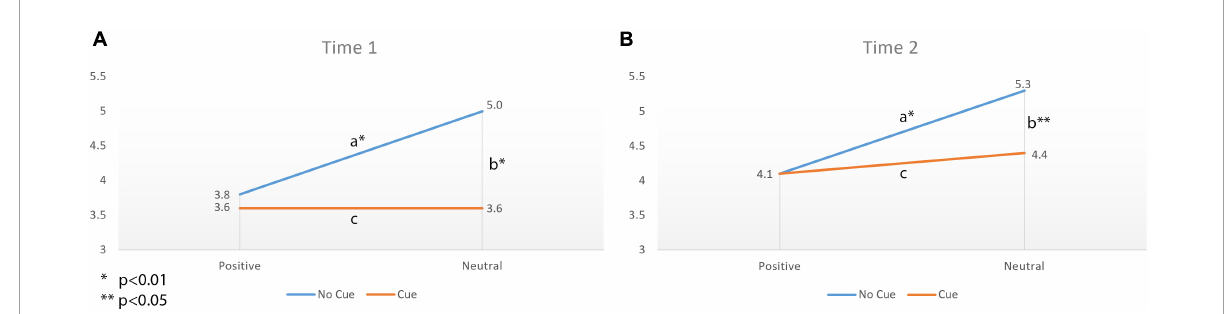
FIGURE1 Experiment 2: Purchase intention as a function of positive affect and omission cuing at (A) Time 1 and (B) Time 2. Note: the repeated measures analysis shows a significant difference at both Time 1 and Time 2 between Neutral-No-Cue condition and Positive-No-Cue condition (a) as well as between Neutral-No-Cue condition and Neutral-Cued condition (b), but no significant difference between the two cued conditions (c).